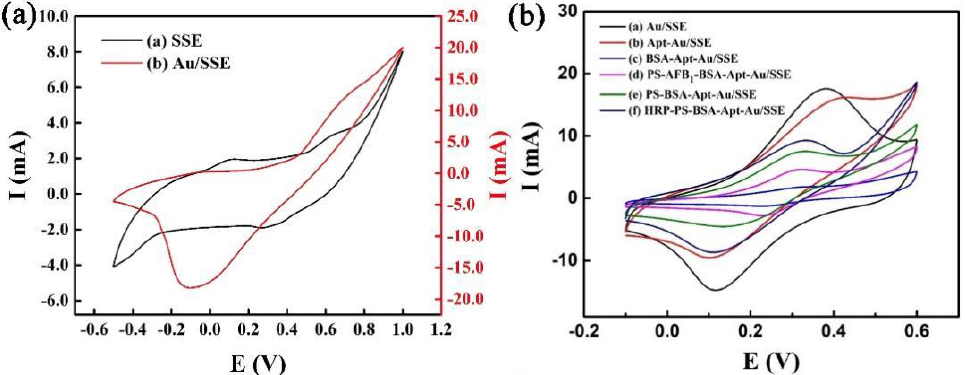
Figure 3. ( a ) CVs of the SSE (black line) and Au/SSE (red line) electrodes recorded in 0.1 M NaOH with a scan rate of 10 mV s − 1 . ( b ) CVs of the as-prepared electrodes recorded in 1 mM [Fe(CN) 6 ] 3− with a scan rate of 10 mV s − 1 .